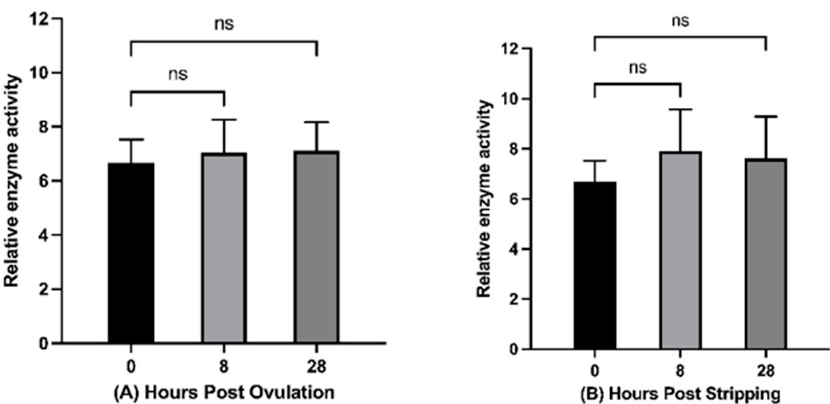
Figure 2. Effect of in vivo ( A ) and in vitro ( B ) oocyte aging at 20 °C on the histone acetyltransferase activity in common carp ( p < 0.05, Tukey’s multiple comparisons test; ns: non-significant; mean ± SEM).